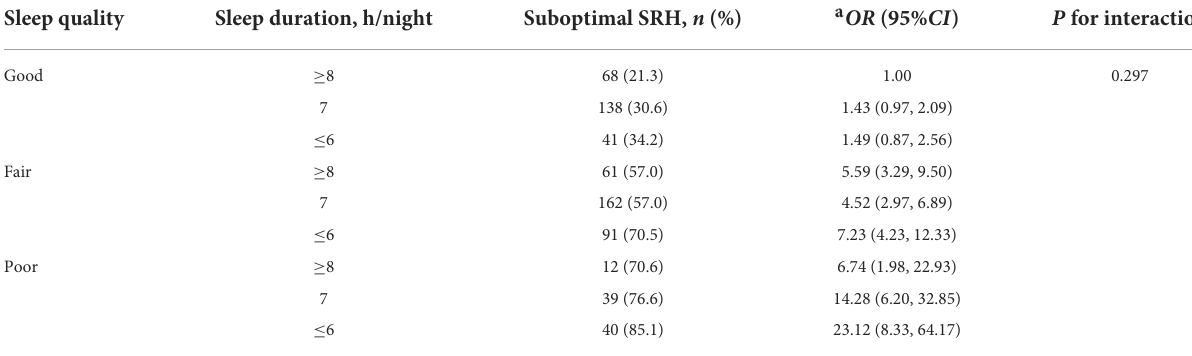
TABLE 5 Joint effects of sleep duration and sleep quality on suboptimal self-rated health. Sleep quality Sleep duration, h/night Suboptimal SRH, n (%) a OR (95% CI ) P for interaction Good ≥ 8 68